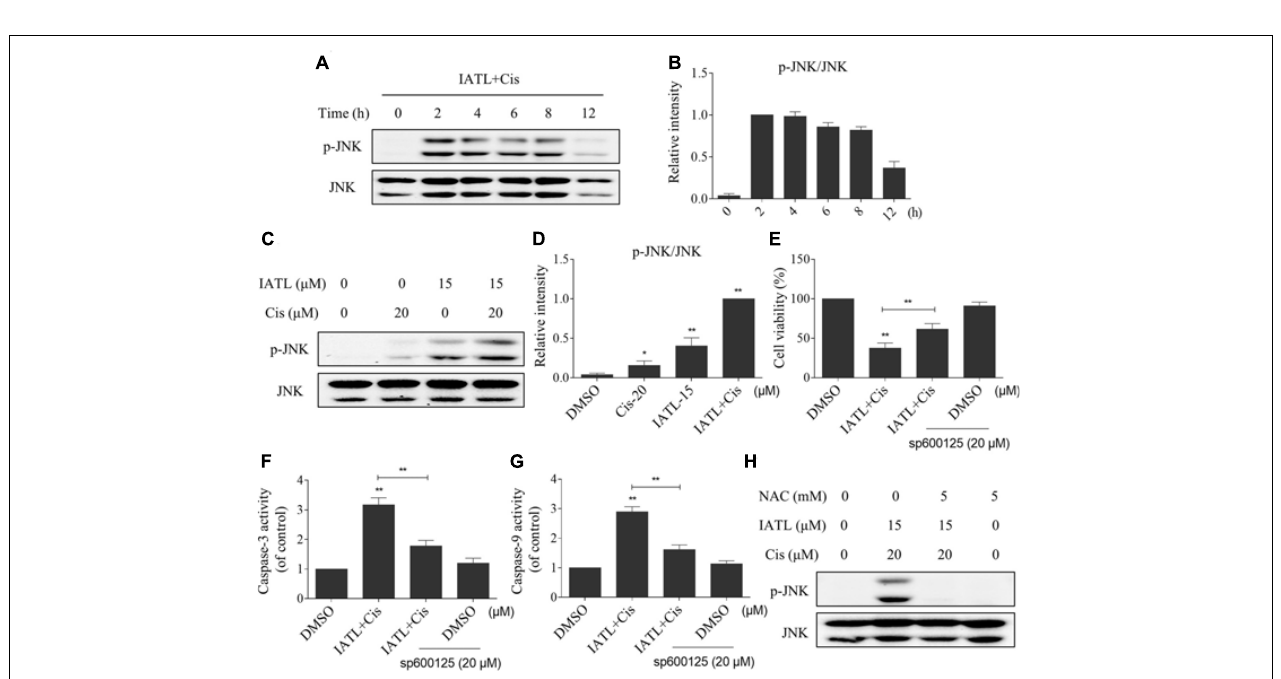
FIGURE 5 | IATL and cisplatin co-operate to induce JNK phosphorylation in prostate cancer cells. (A,B) DU145 cells were treated with the combination of IATL (15 µ M) and cisplatin (20 µ M) for the indicated time periods; the expression of p-JNK and JNK was measured by Western blot. (C,D) DU145 cells were treated with IATL (15 µ M) or cisplatin (20 µ M) alone or their combination (15 µ M IATL and 20 µ M cisplatin); the expression of p-JNK and JNK was measured by Western blot. (E) DU145 cells were preincubated with SP600125 for 2 h; cell viability was detected by an MTT assay after being treated with the combination of IATL (15 µ M) and cisplatin (20 µ M) for 24 h. (F,G) DU145 cells were preincubated with SP600125 for 2 h before being treated with the combination of IATL (15 µ M) and cisplatin (20 µ M) for 20 h; caspase-3 and caspase-9 activity was measured by an assay kit. (H) DU145 cells were preincubated with NAC (5 mM) for 2 h before being treated with the combination of IATL (15 µ M) and cisplatin (20 µ M); the expression of p-JNK and JNK was measured by Western blot. * p < 0.05, ** p < 0.01.